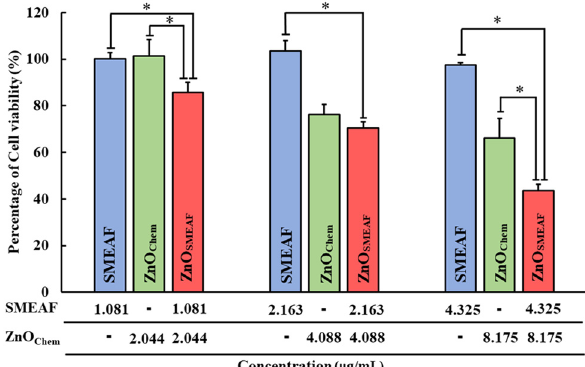
Figure 8: Cytotoxicity of SMEAF, ZnO Chem , and ZnO SMEAF against HCT - 116. Cells were treated with each sample for 72 h before cell viability was determined using MTT assay. Error bars represent standard deviation in measurement, and a signi fi cant di ff erence was set at p ≤ 0.05 ( n > 3 )